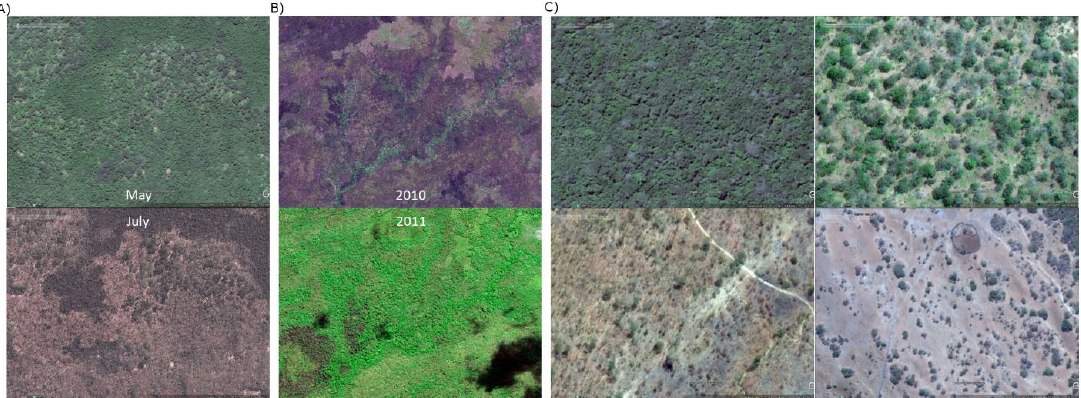
Figure 1. Challenges of tropical dry forests monitoring ( A ) Deciduous vegetation—same forest area in the humid (May) and the dry (July) season, ( B ) Fires—same forest area affected (2010) or not (2011) by fire, ( C ) Four different areas illustrating the variety of tree cover. “Maps data: Google, © 2021 Maxar Technologies”.